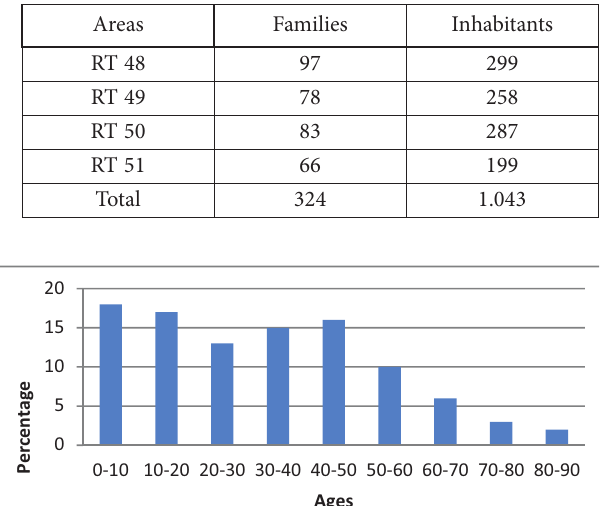
Figure 3. The age percentage of Kampong Pakuncen population (organized from the kampong data)